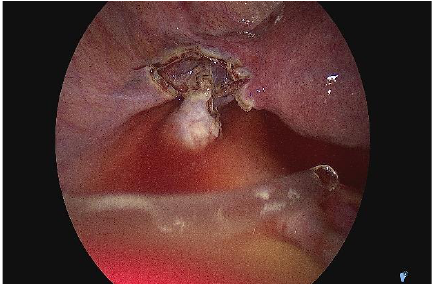
Figure 5. ( a ) Intra-operative image indicating the gestational sac on the left fallopian tube. ( b ) Intra-operative image indicating the gestational sac on the left fallopian tube.